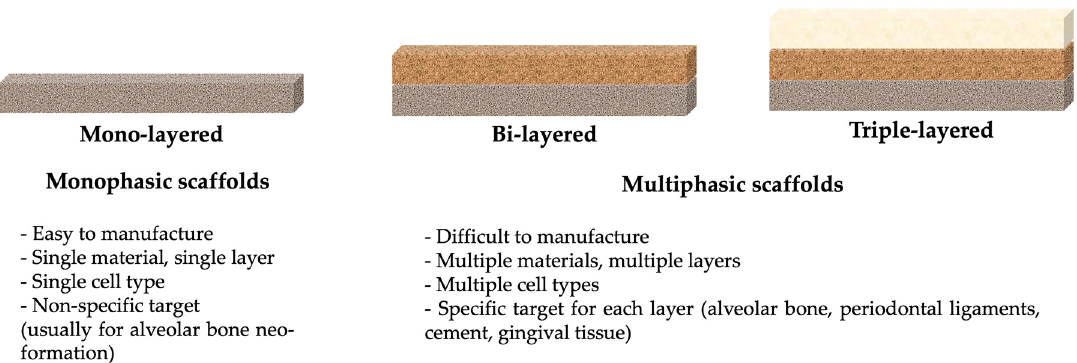
Figure 9. Schematic view of monophasic and multiphasic scaffolds.